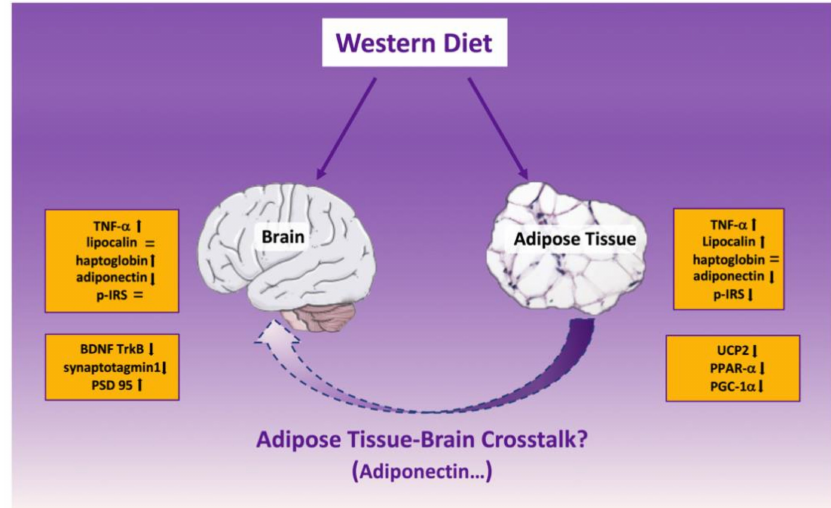
Figure 12. Summary of the modifications induced by high fat-high fructose (western) diet in brain (hippocampus and cortex) and white adipose tissue from middle-aged rats. UCP2 = uncoupling protein 2 PPAR- α = peroxisome proliferator activated receptor alpha, PGC-1 α = peroxisome proliferator-activated receptor gamma coactivator 1-alpha, TNF- α = tumor necrosis factor alpha, p-IRS = phosphorylated insulin receptor substrate, BDNF = brain derived neurotrophic factor, TrkB = tropomyosin receptor kinase